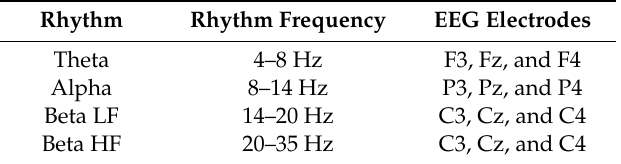
Table 1. Electroencephalogram (EEG) rhythm ranges used in the